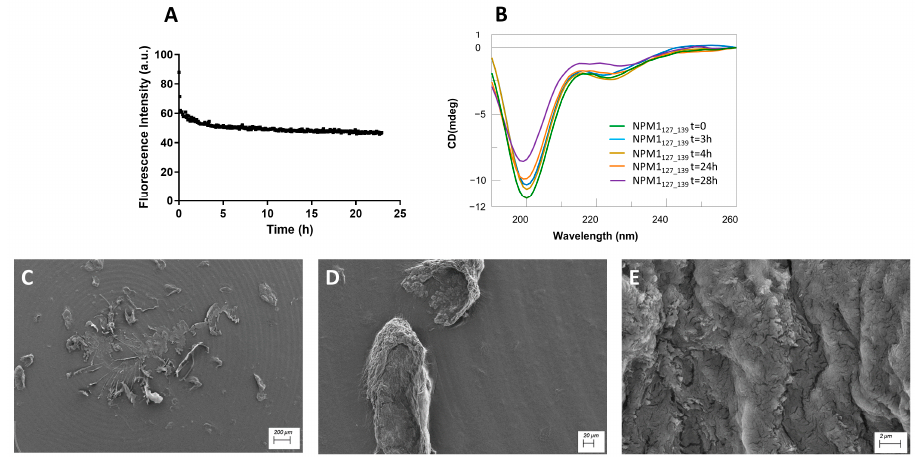
Figure 6. NPM1 127–139 characterization: ( A ) Time course of ThT fluorescence emission intensity; ( B ) CD spectra over time; ( C – E ) SEM micrographs registered at 24 h at 100, 20 and 2 µm.